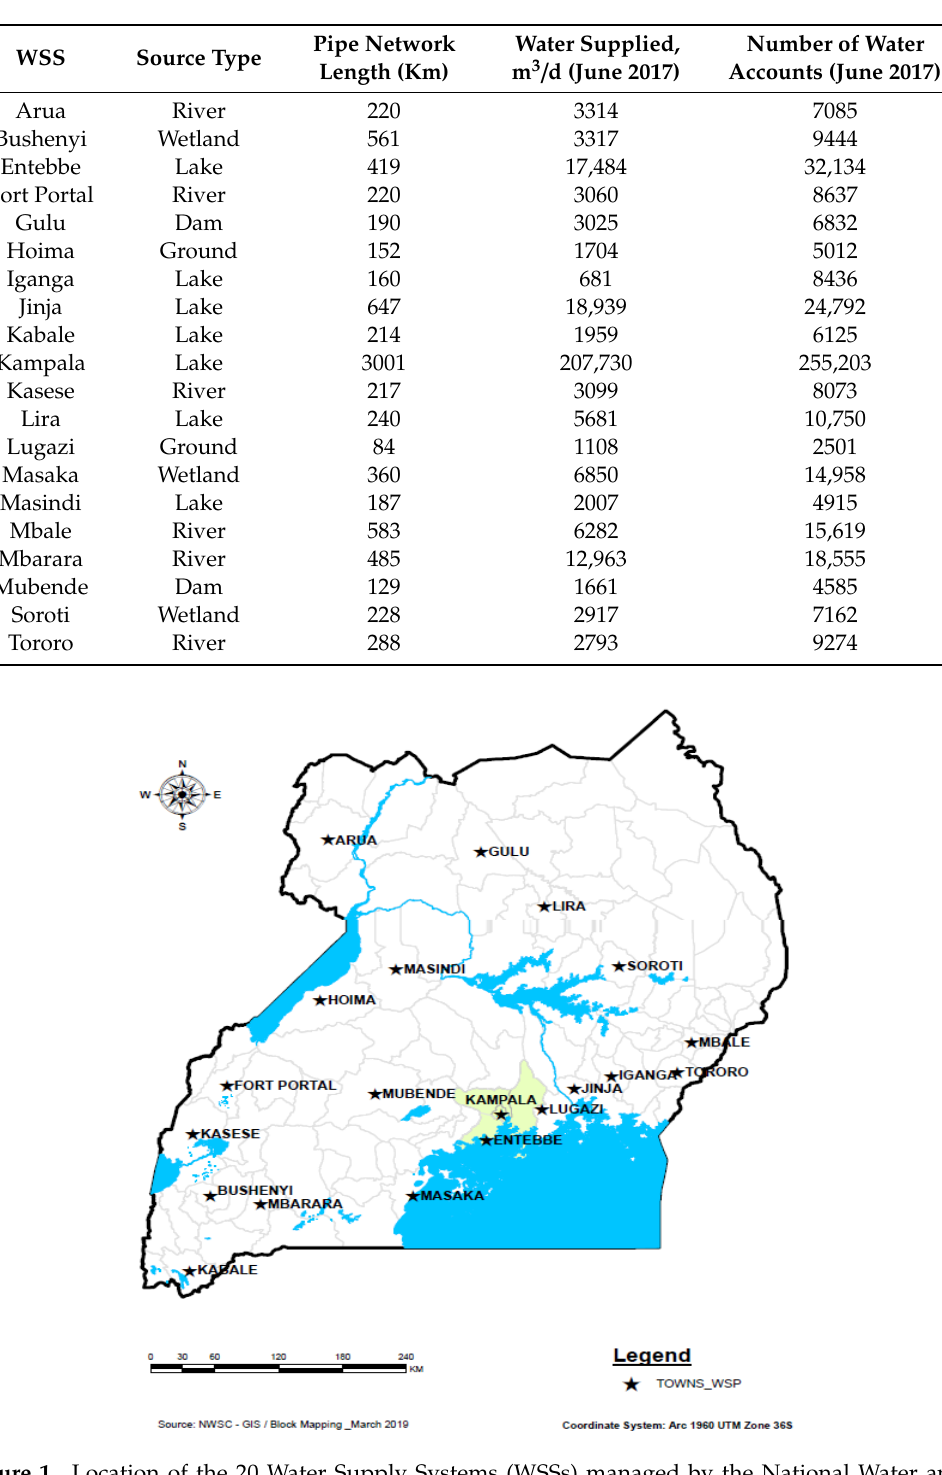
Table 1. Characteristics of the 20 WSSs.